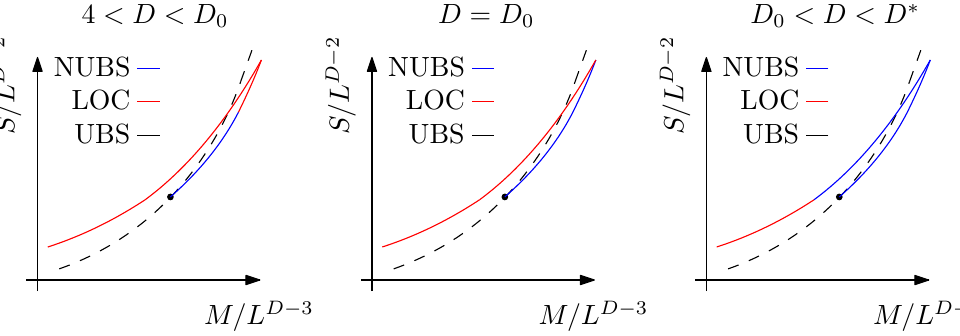
Figure 1 . Schematic phase diagrams in the microcanonical ensemble for various D ’s. Here D 0 = 10 is the critical dimension of the double-cone geometry [34] and D (cid:3) = 13( : 5) is the critical dimension in the microcanonical ensemble